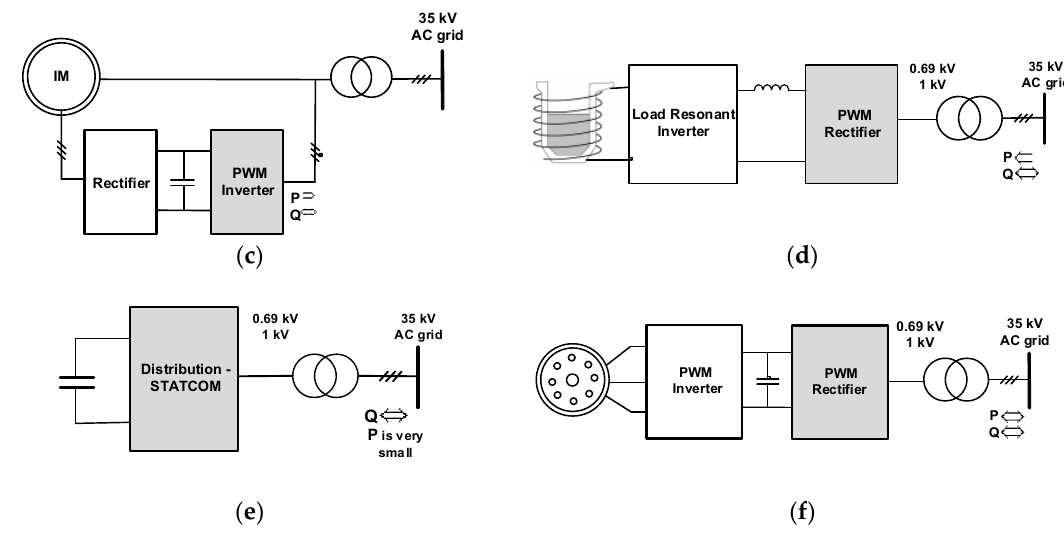
Figure 1. Possible application areas of the selective harmonic elimination method (SHEM) in grid ‐ connected voltage source converter (VSC) applications. ( a ) Single ‐ stage grid ‐ connected photovoltaic (PV) supply, ( b ) wind energy conversion system with a permanent magnet synchronous generator (SG), ( c ) Subsynchronous slip ‐ energy recovery drive or double ‐ output induction generator, ( d ) Medium ‐ power induction melting furnace, ( e ) Distribution static synchronous compensator (STATCOM), and ( f ) Variable frequency alternating current (AC) motor drive. PWM, pulse ‐ width modulator.